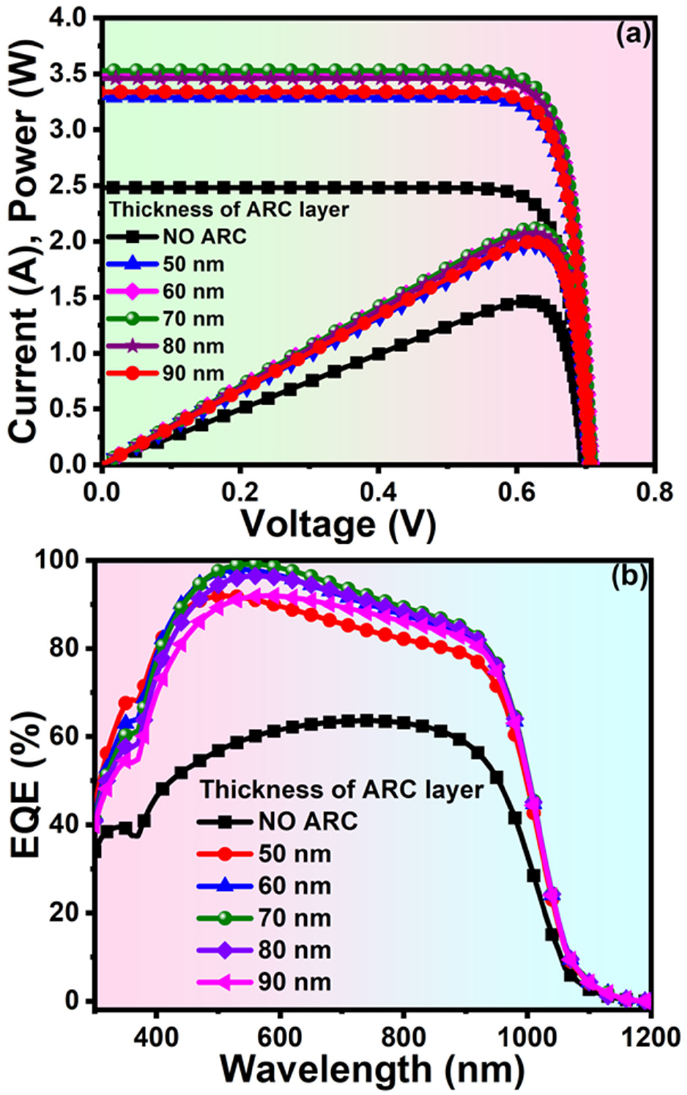
Figure 11. Analysis of ( a ) I, P-V characteristic ( b ) External Quantum efficiency of ARC layer-based c-Si solar cell.